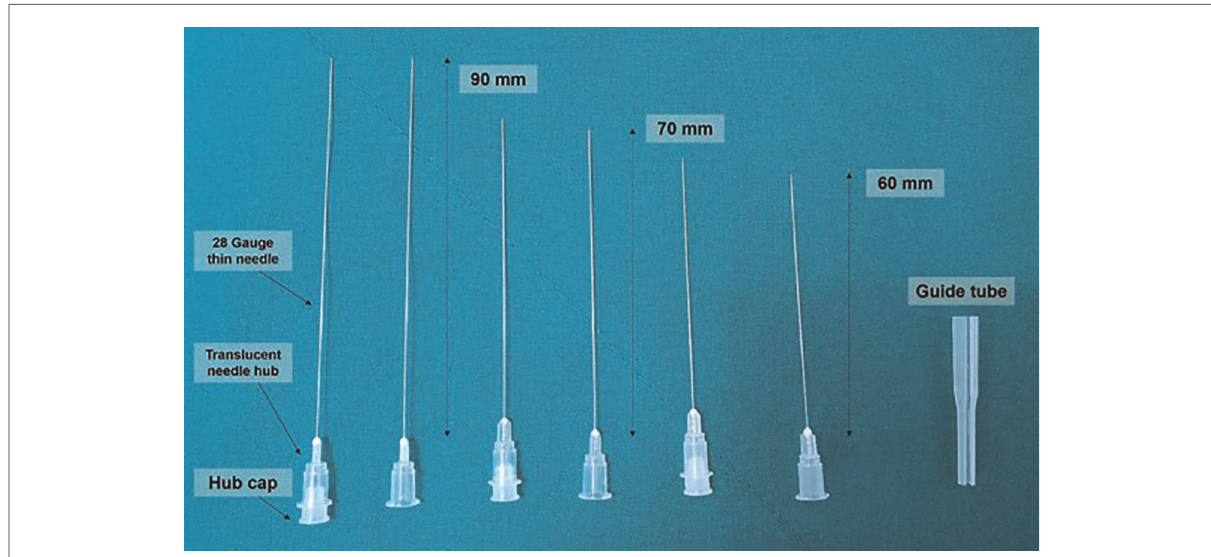
FIGURE 2 Newly designed 28G 60 – 90-mm thin hypodermic needles. Newly designed 28G 60 – 90-mm thin hypodermic needles were used. New needles with a transparent plastic needle hub and hub cap prevented complications, such as unintentional nerve and vessel injuries by the needles or by anesthetic injection, by con fi rming the presence or absence of blood or cerebrospinal fl uid without the need for aspiration. The needle guide is used to adjust the direction of the needle or for direction